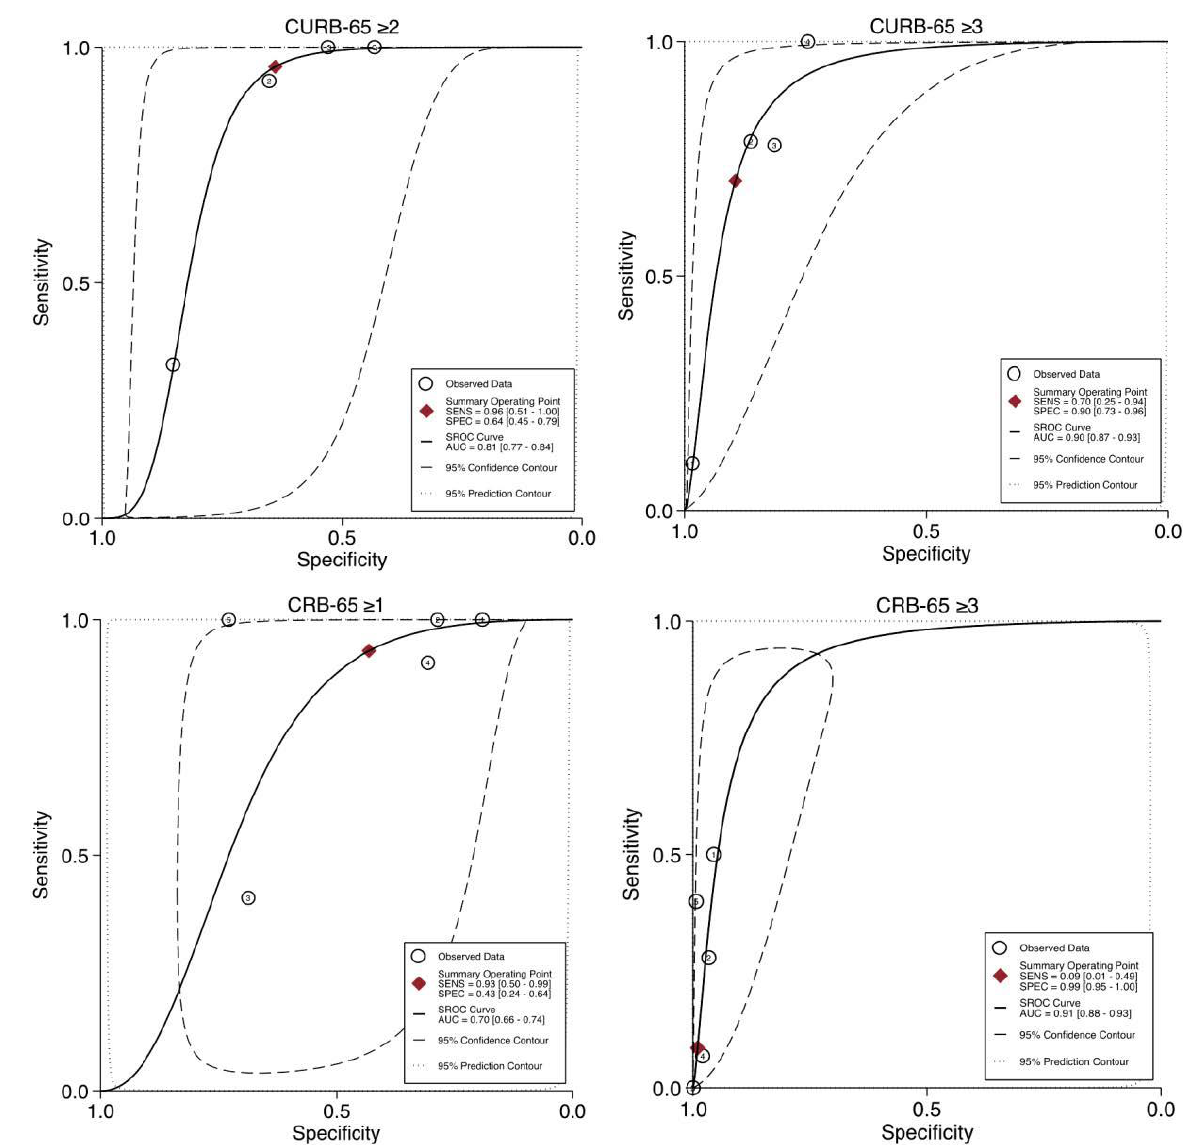
Figure 5. Area under the receiver operating characteristic (AUROC) curves for the included studies examining CURB-65 and CRB-65 at the studied cut-offs for mortality prediction. The numbers in the circle refer to the included studies.